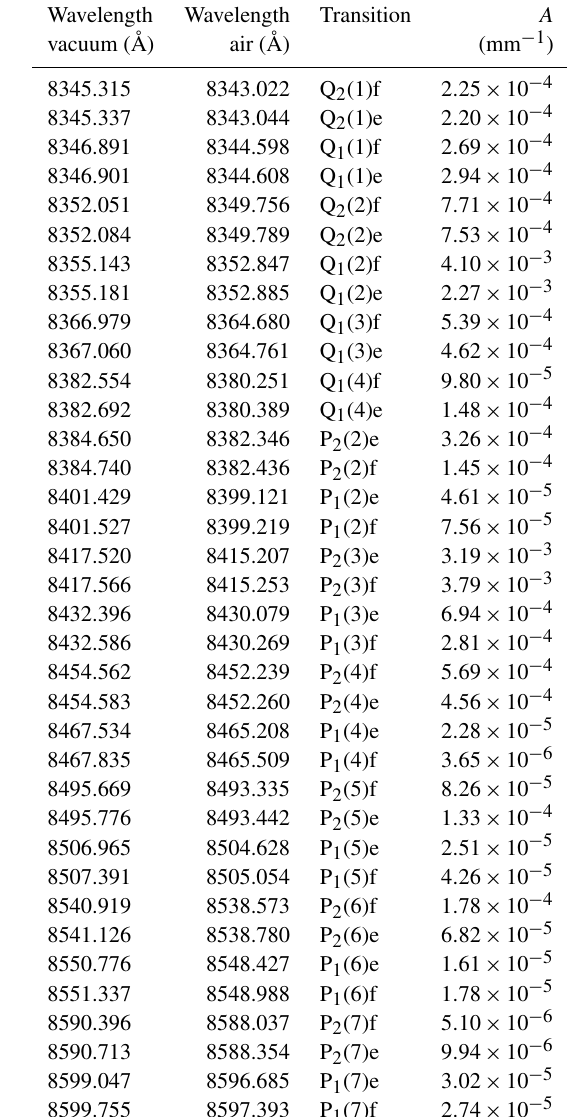
Table 4. Water vapour transmission at wavelengths of OH(6–2) lines. Vacuum wavelengths are from Rousselot et al. (2000), with conversion to air wavelengths undertaken as specified by Ciddor (1996). At each wavelength, water vapour transmission is given by a function of PWV: T λ = exp ( − A × PWV ) , with PWV in